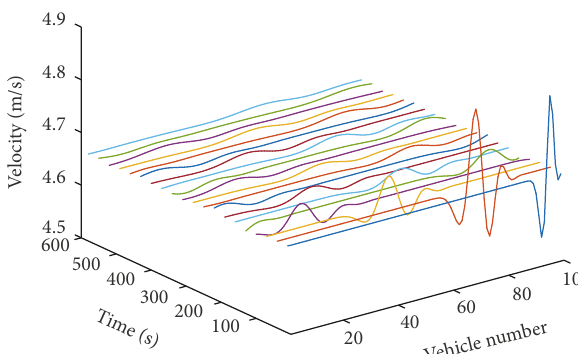
Figure 7: Velocity variation of all vehicles for switched cooperative driving model.